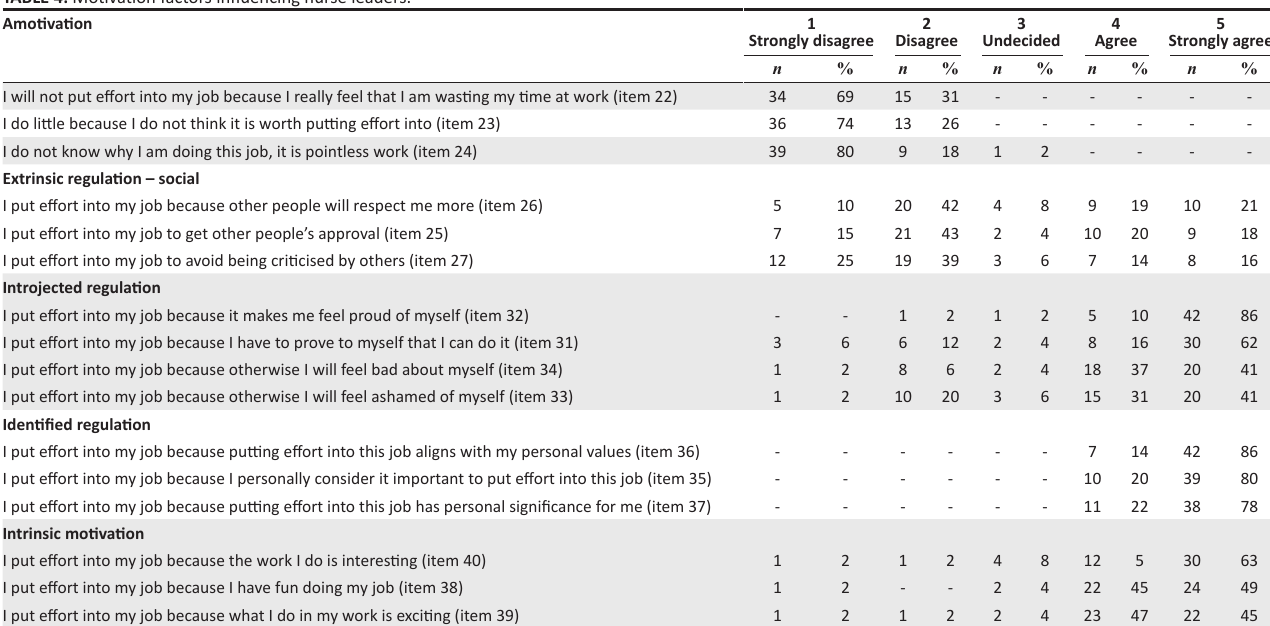
TABLE 4: Motivation factors influencing nurse leaders.